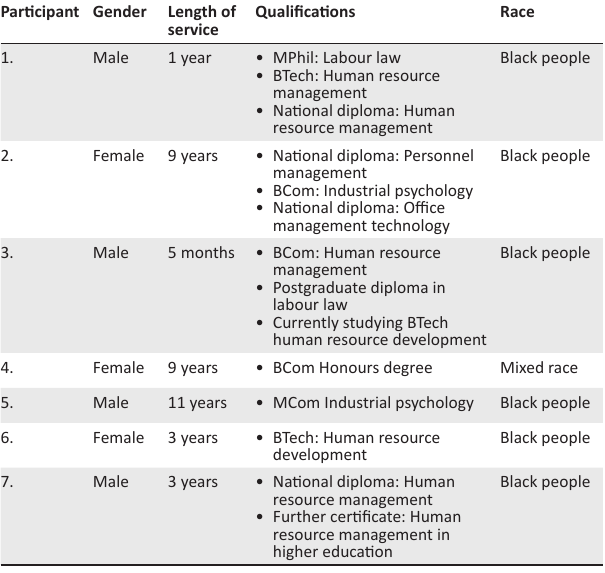
TABLE 2: Demographic profile of human resource professionals as